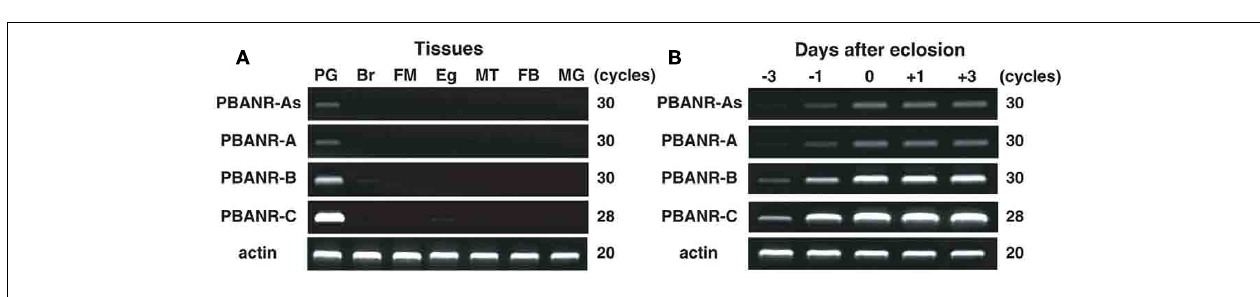
developmental stages. PGs were dissected from p50 female pupae at 3days ( − 3) and 1day ( − 1) before eclosion and from p50 adults at 0day (0), 1day ( + 1), and 3days ( + 3) after eclosion. cDNAs were normalized to actin expression levels.The PCR cycle number is indicated to the right of the